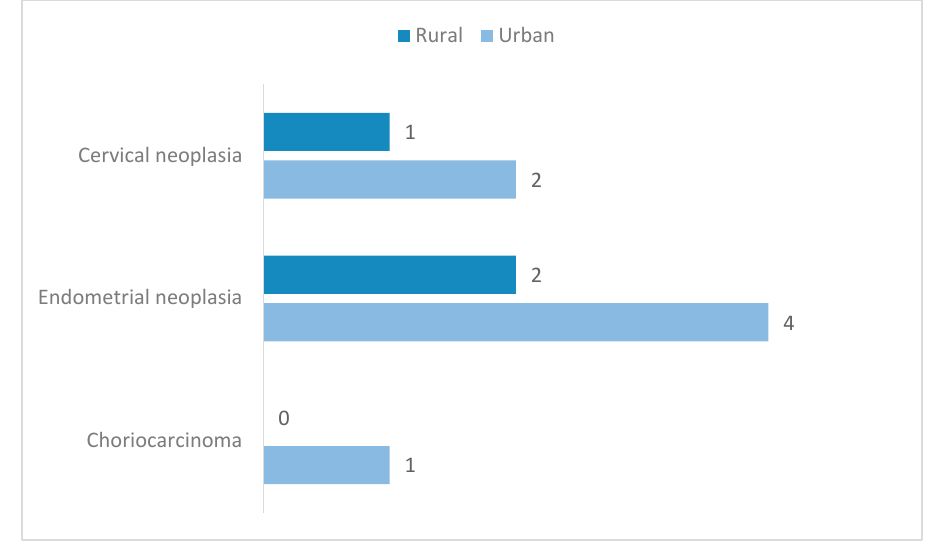
Figure 3. Distribution of patients with histopathological identified neoplasms according to age .